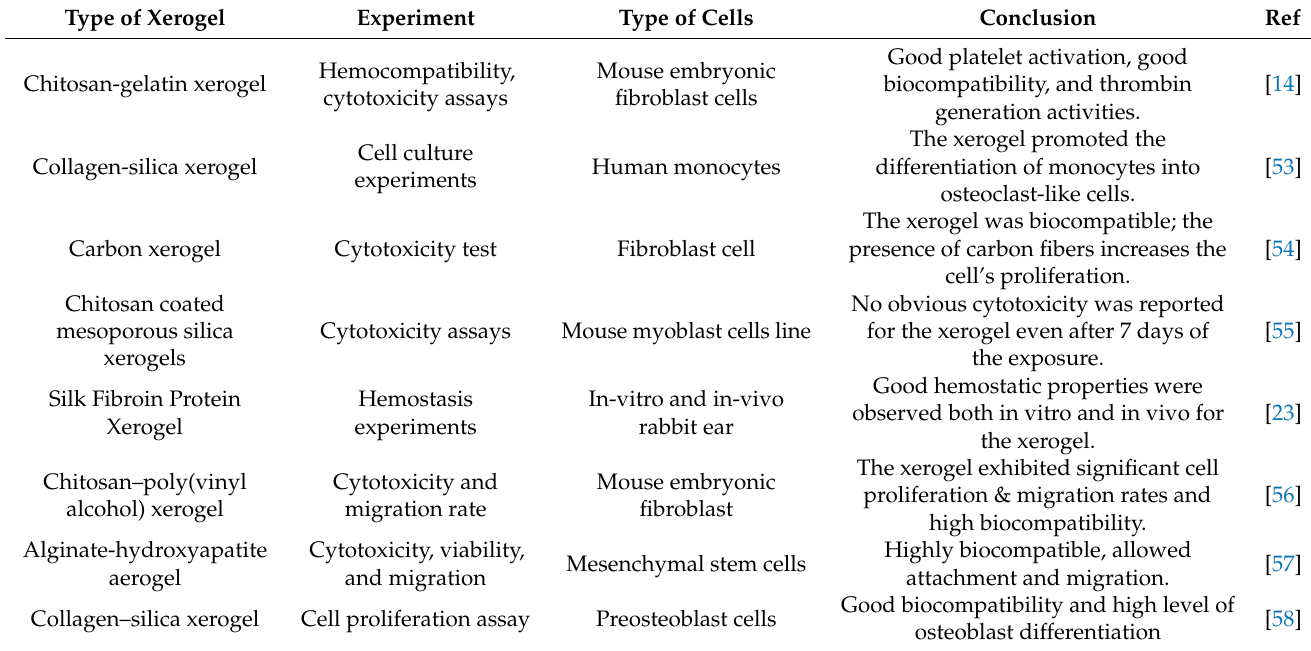
Table 1. Illustration of biocompatibility and cytotoxicity studies of biopolymer-based